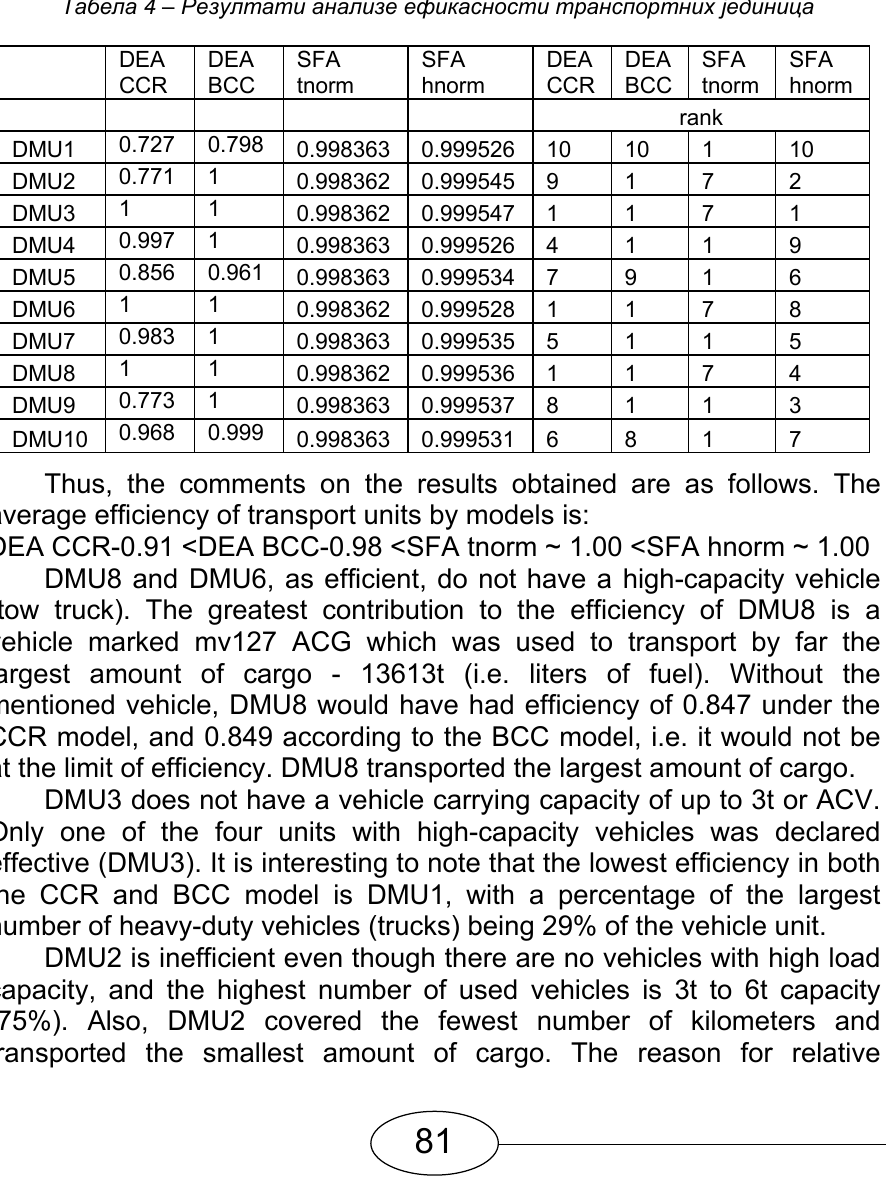
Table 4 – Results of the analysis of the efficiency of transport units Таблица 4 – Результаты анализа эффективности транспортных единиц Ta бела 4 – Резултати анализе ефикасности транспортних